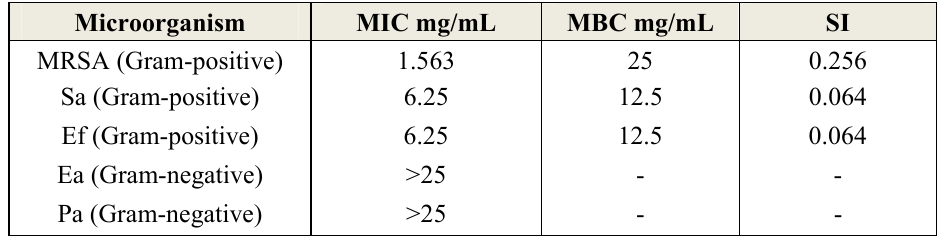
Table 4. Minimum inhibition concentration (MIC) (mg/mL), minimum bactericidal concentration (MBC) (mg/mL) and selectivity index (SI) of C-5-bromo-2- hydroxophenylcalix[4]-2-methylresorcinarene ( I ). Microorganism MIC mg/mL MBC mg/mL SI MRSA (Gram-positive) 1.563